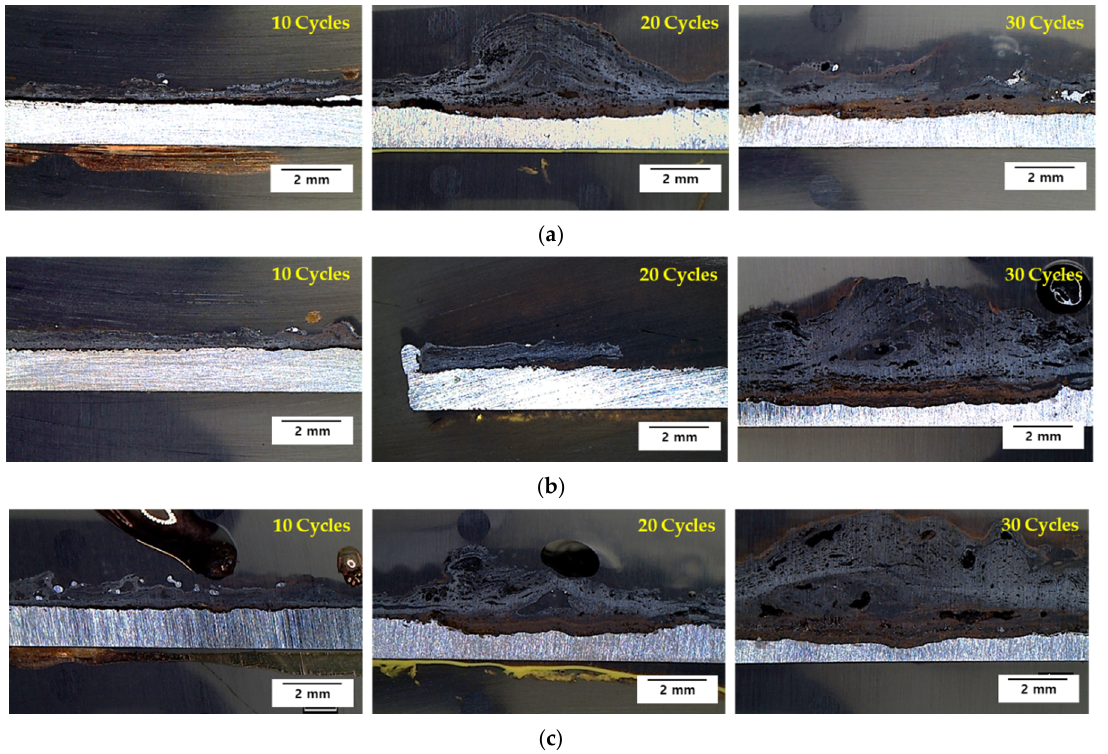
Figure 6. Cross-section OM images of ( a ) 0 Cr steel, ( b ) 0.3 Cr steel, and ( c ) 0.5 Cr steel after CCT.